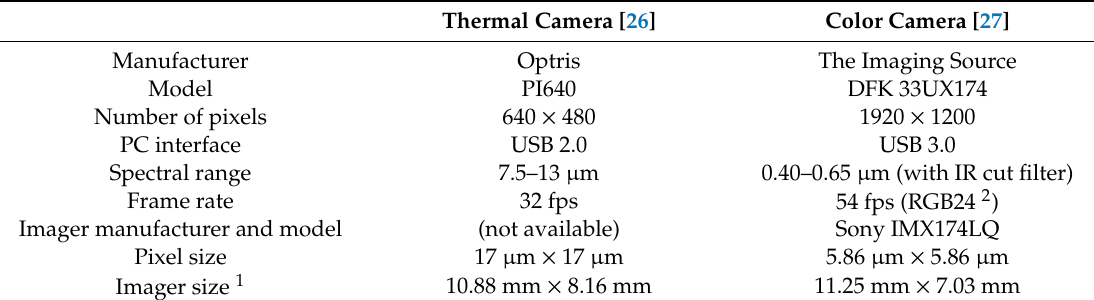
Table 1. Specifications of thermal and color cameras.